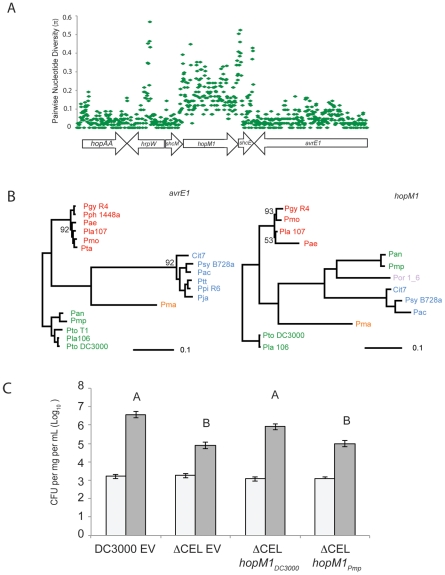
Recombination of hopM1 in group I strains leads to functional divergence.(A) A genomic region including hopM1 was aligned for all group I P. syringae strains with draft genome sequences and pairwise nucleotide diversity values (π) were calculated in 25 bp sliding windows. (B) Phylogenies were constructed using Bayesian methods for both avrE1 and hopM1 for all publicly available alleles. Posterior probabilities are shown if support for nodes is <0.99. Color-coding of strain names represents phylogenetic group designation as described in Figure 1. (C) schM/hopM1 from Pmp is unable to complement the virulence defect of Pto DC3000 ΔCEL in dip assays on Arabidopsis. Bars indicate mean growth at zero and four days after inoculation. Error bars are 2× standard error. Different letters indicate statistically significant differences (ANOVA, Tukey's HSD).